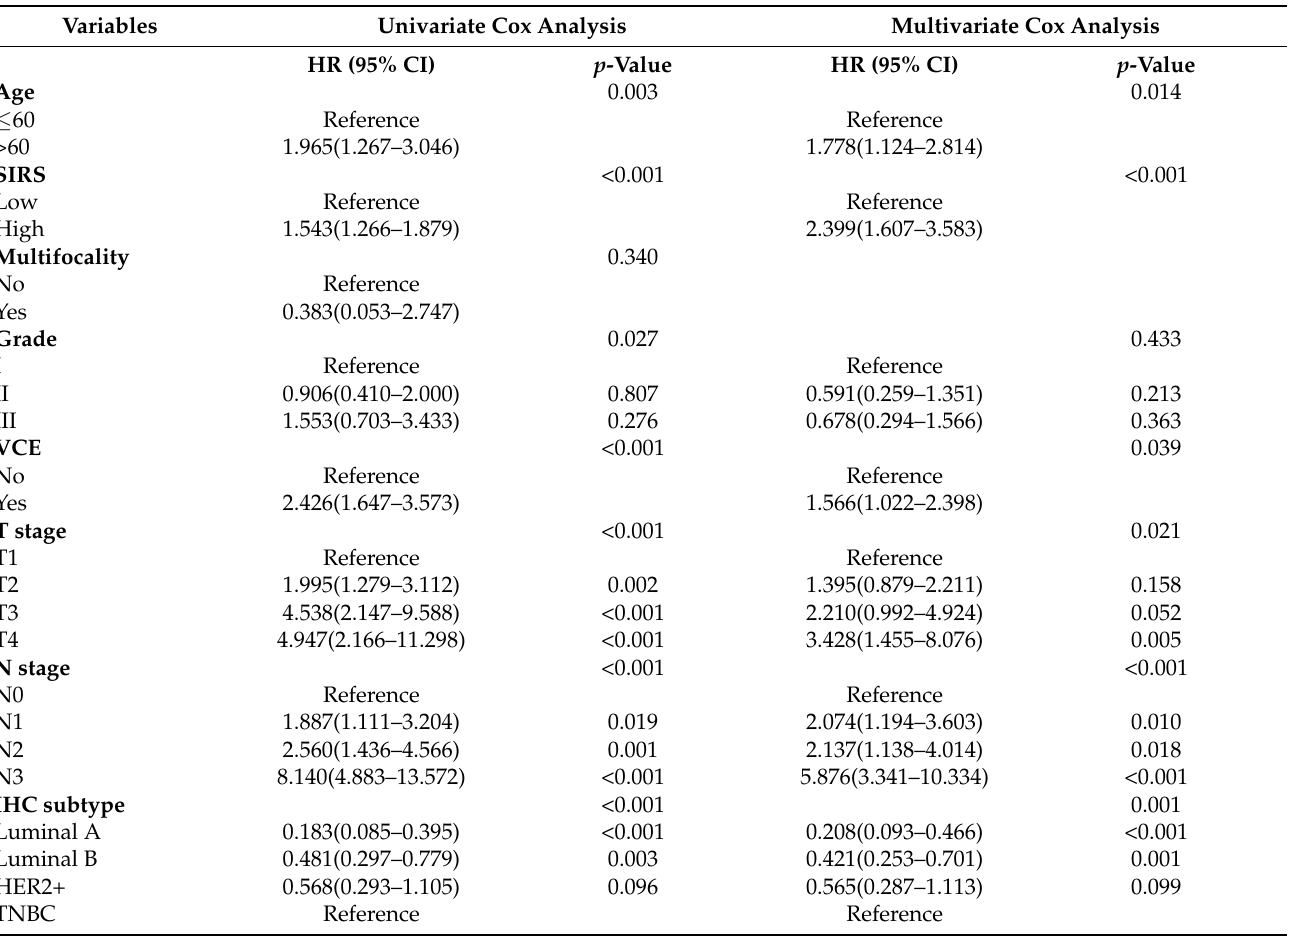
Table 3. Results of the univariate Cox regression analysis and multivariate Cox regression analysis for OS among the clinical characteristics and